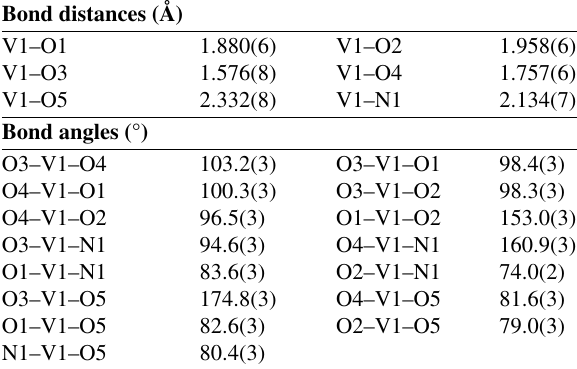
Table 2. Selected bond lengths (Å) and angles (°) for the complex with estimated standard deviations (e.s.d.s) in